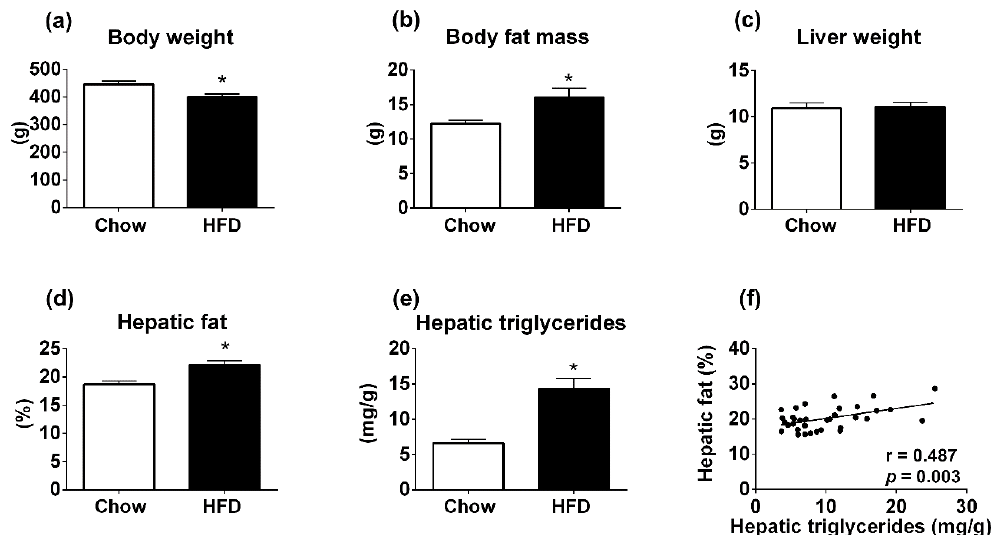
Figure 1. Metabolic parameters of Wistar rats consuming normal chow or high-fat diet (HFD) for 12 weeks. ( a ) Body weight (chow group, n = 20; HFD group, n = 15). ( b ) Body fat mass determined by summing the masses of the epididymal and retroperitoneal fat pads. ( c ) Liver weight. ( d ) Percentage of hepatic fat measured by time-domain nuclear magnetic resonance (TD-NMR). ( e ) Hepatic triglyceride (TAG) measured by calorimetric assay. ( f ) Linear correlation between hepatic fat measured by TD-NMR and hepatic TAG determined by colorimetric assay. * p < 0.05 versus chow group (Student’s t -test).